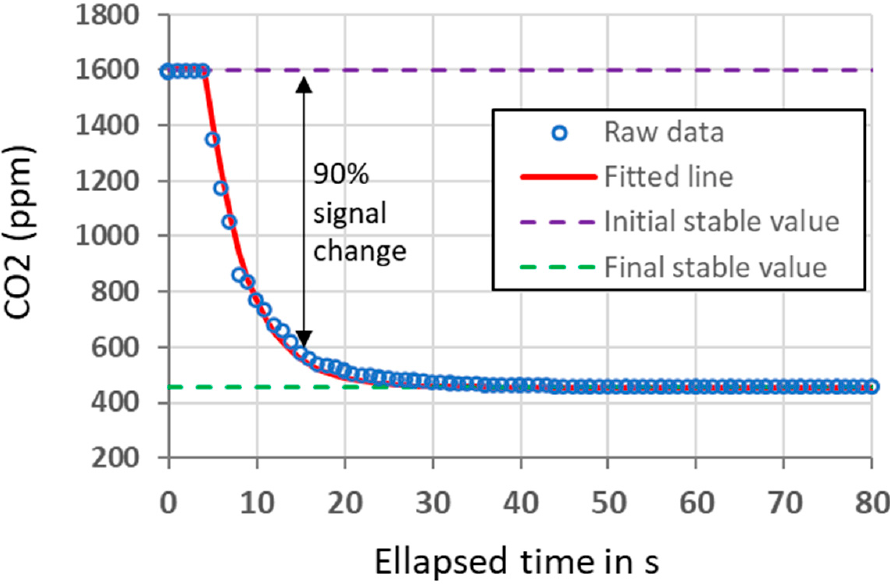
Figure 6. CO 2 measured by one K96 sensor during the ‘fall’ response time experiment. At t = 0 s, the exposition chamber was lifted and the sensor, previously flushed with a high CO 2 concentration from a cylinder, became exposed to room air.